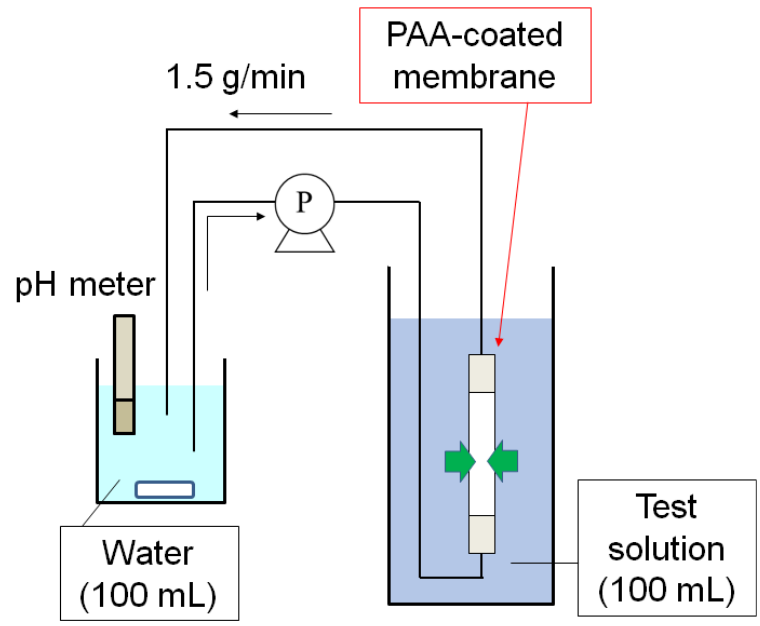
Figure 2. Permeation test system with circulation.